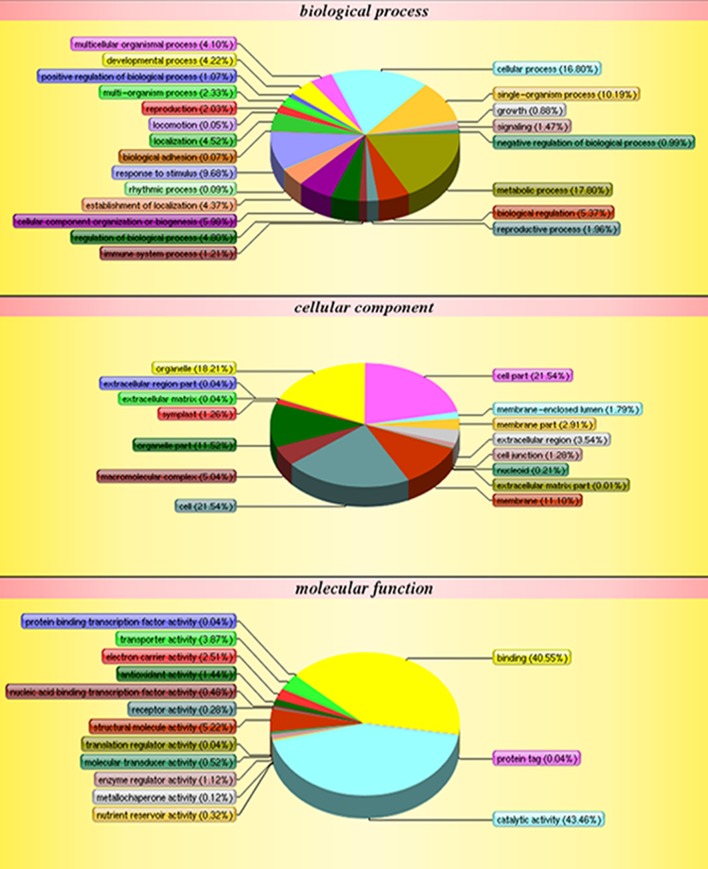
GO classification of all protein.